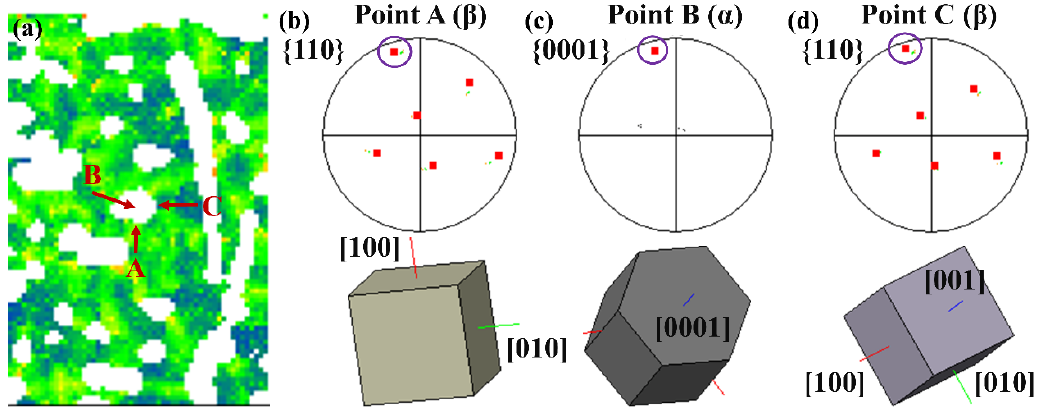
Figure 8. ( a ) The KAM values map of the β phase in local areas circled in Figure 4b; ( b ) the {110} β pole figure at arrow A; ( c ) the {0001} α pole figure at arrow B; ( d ) the {110} β pole figure at arrow C.